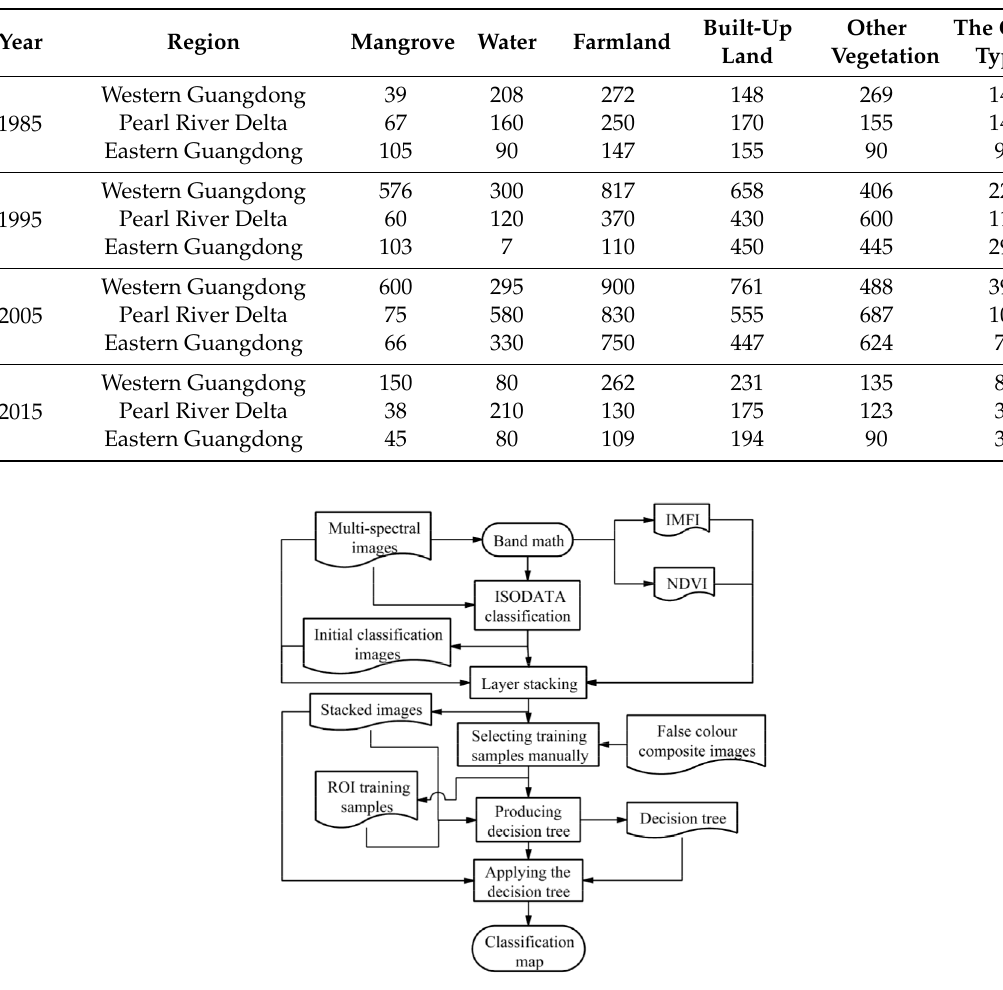
Figure 2. Flow chart of the classification process by using the Classification and Regression Tree (CART) algorithm. Table 1. Interpretation keys of all land cover types.